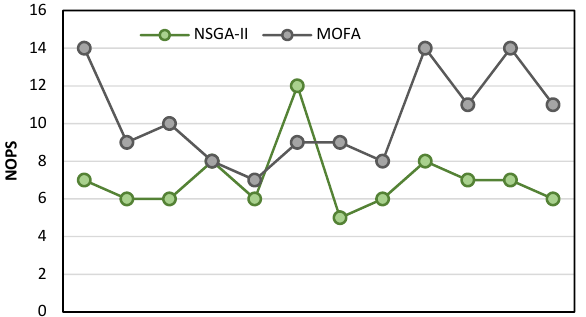
Figure 10. NSGAII and MOFA comparison based on the number of Pareto solutions.